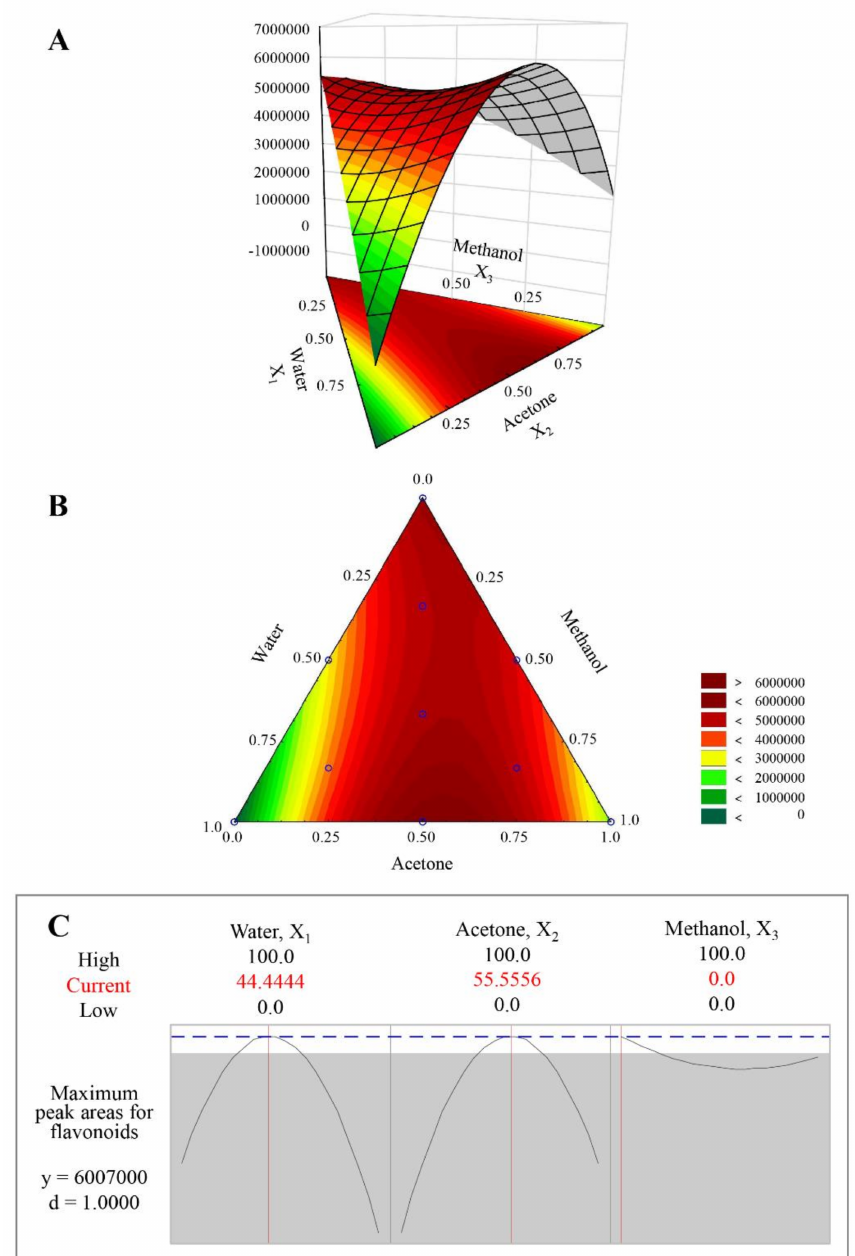
Figure 3. ( A ) 3D Response surface, ( B ) 2D Contour plot, and ( C ) optimization diagram obtained from mixture design for the solvent mixture of maximum flavonoids extraction